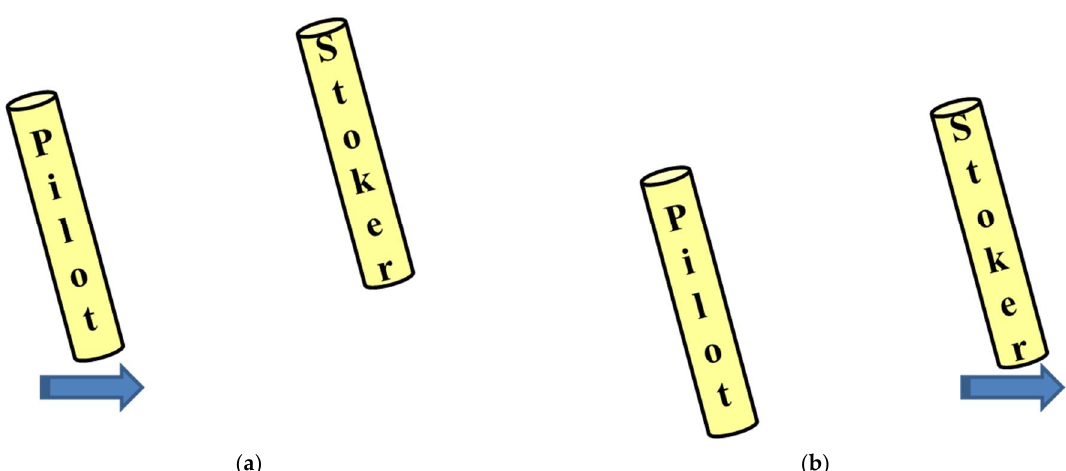
Figure 7. Schematics illustrating the flow around both legs at 90 degrees (Figure 5c). The wind direction is from the left to the right. ( a ) the stoker’s leg is at the top (the pilot’s leg is in front); ( b ) the pilot’s leg is at the